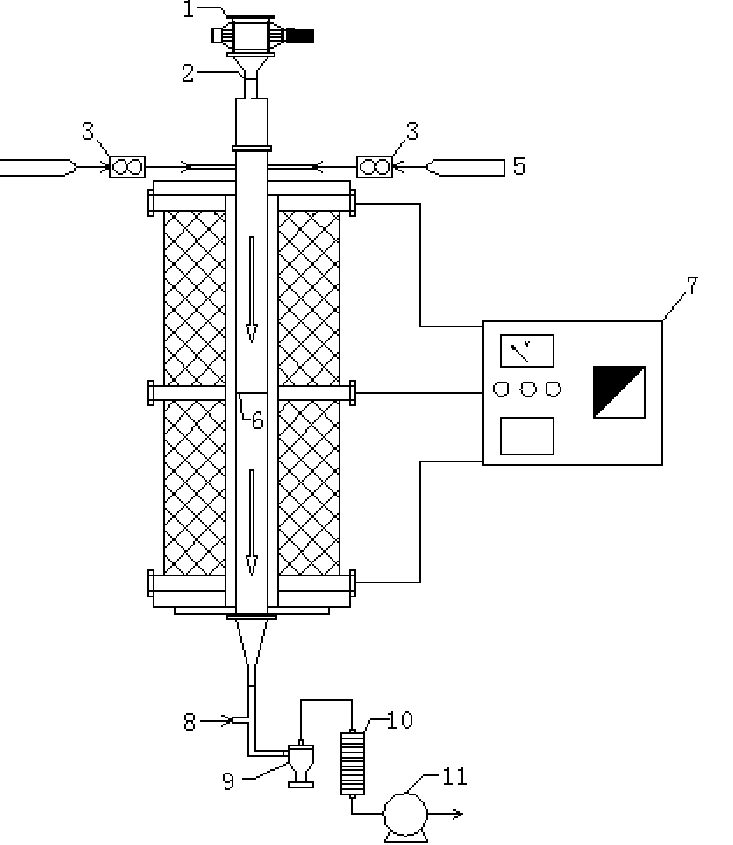
Figure 1. Schematic diagram of experimental device [9]. 1. Feeding system, 2. feed inlet, 3. mass flowmeter, 4. nitrogen, 5. oxygen, 6. steel multihole distributor, 7. temperature controller, 8. dilution air, 9. cyclone, 10. Dekati low-pressure impactor, and 11. vacuum pump.